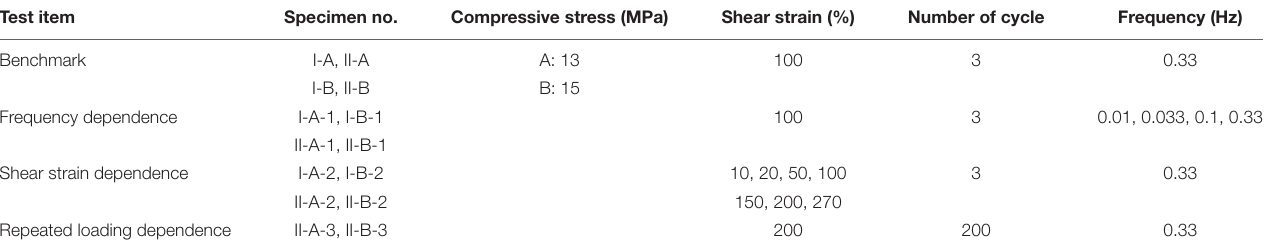
TABLE 2 | Summary of test conditions.